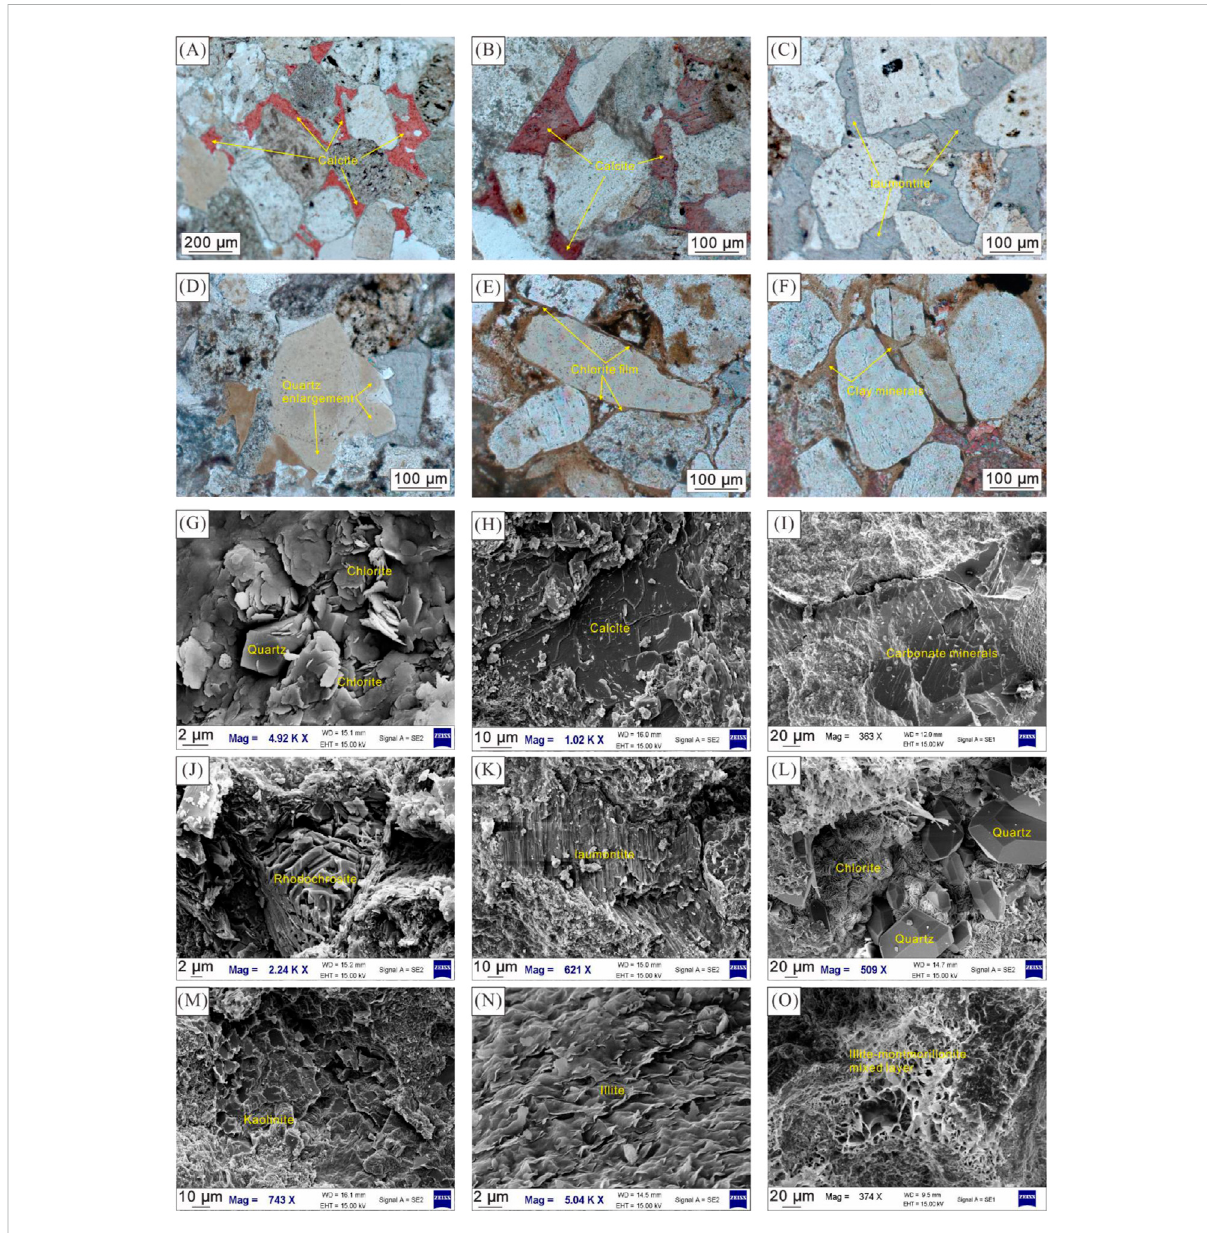
FIGURE 9 Cementation characteristics of the P 3 w reservoirs in Fukang Sag (A) Well Fu48, 4492.66 m, P 3 w, and calcite cementation; (B) Well Fu49, 5402.69 m, P 3 w, and calcite cementation; (C) Well Fu48, 4537.95 m, P 3 w, laumontite cementation; (D) Well Fu48, 4471.00 m, P 3 w, and secondary enlargement of quartz; (E) Well Fu49, 5384.00 m, P 3 w, and clay cementation; (F) Well Fu49, 5384.00 m, P 3 w, and intergranular clay- fi lled; (G)